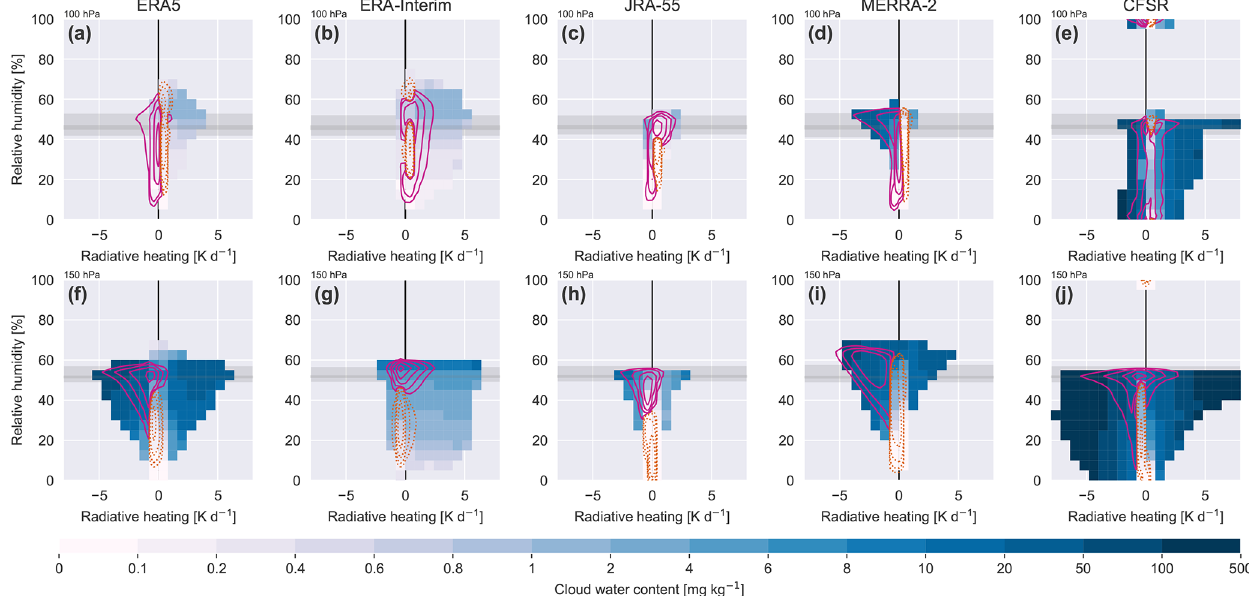
Figure 12. Composite distributions of daily-mean CWC as a function of radiative heating rate and grid-scale relative humidity (RH) in (a, f) ERA5, (b, g) ERA-Interim, (c, h) JRA-55, (d, i) MERRA-2, and (e, j) CFSR on the 100hPa (upper row; a–e ) and 150hPa (lower row; f–j ) isobaric surfaces. RH is calculated with respect to liquid water. Grey shaded regions in each panel mark ranges of ice saturation /e ∗ ratios ( e ∗ ) at these levels, with light shading marking the minimum and maximum and dark shading marking the interquartile range. (cid:96) i Solid pink contours mark paired values of radiative heating and RH that are more commonly associated with cloudy conditions ( Q 4 of the daily-mean LWCRE) than with clear-sky conditions ( Q 1 of LWCRE); dashed orange contours mark the opposite (values more commonly associated with Q 1 than Q 4 ). Composite mean CWCs are masked for bins containing fewer than 200